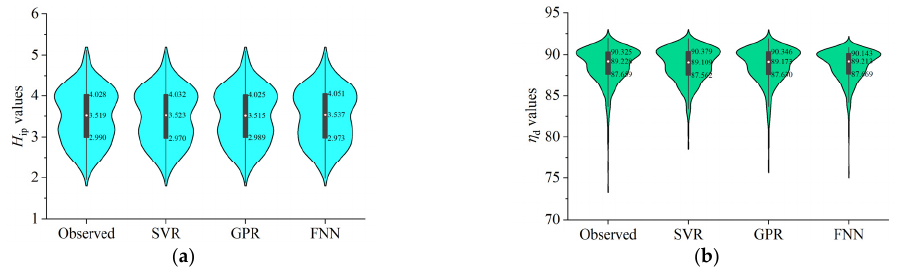
model is closer to the position of the target point, and its prediction results are the most accurate.